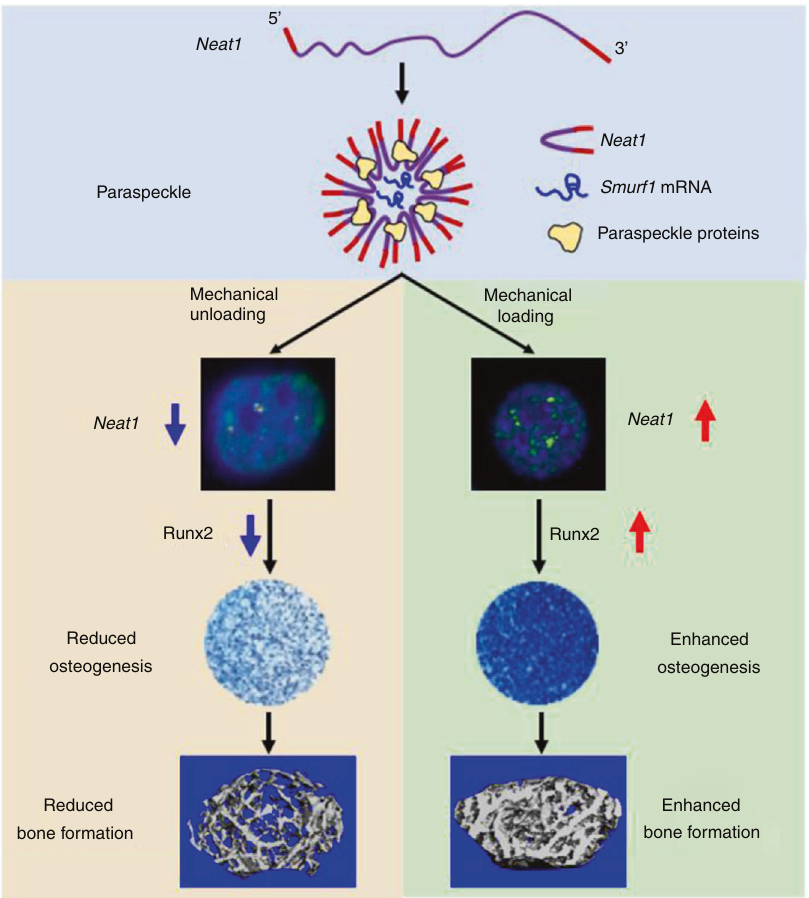
Fig. 8 Proposed model for the regulation of Neat1 -containing paraspeckles on osteoblasts under mechanical stimulation. Neat1 /paraspeckle functions as an important mechanotransducer in response to mechanical stimuli and regulates bone formation (see text for